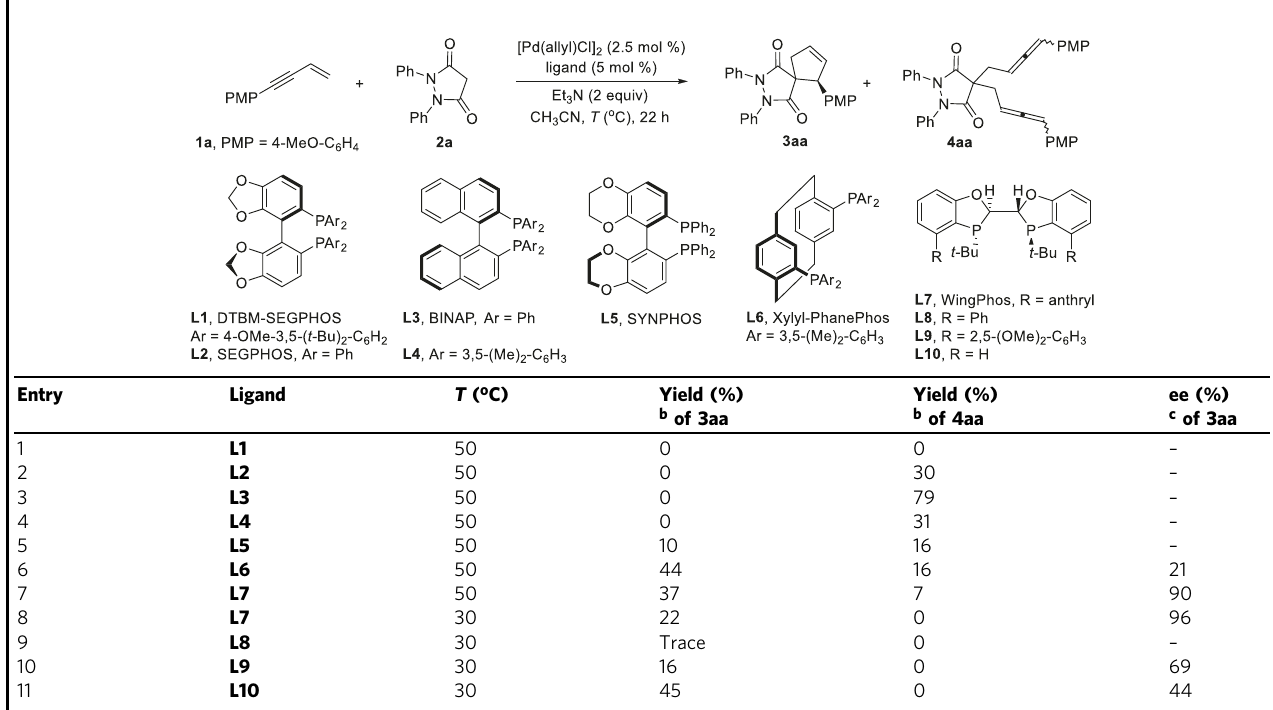
Table 1 Chiral ligand effects on product-selectivity and enantioselectivity a .